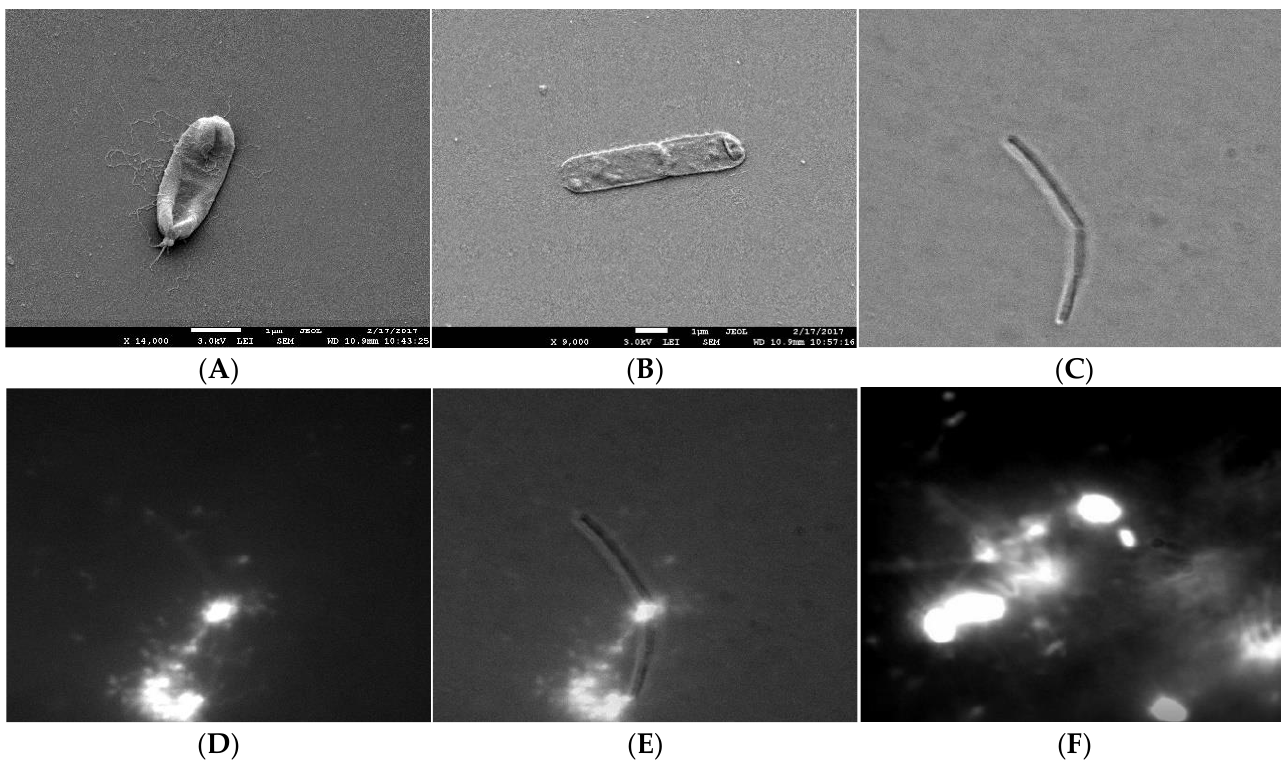
Figure 2. Release of cytosol material during cell lysis. ( A , B ) SEM micrograph of B. subtilis 3610 wt cells in SYM medium grown during cell lysis. The white arrow indicates rupture at the pole. Scale bar represents 1 µ m. ( C ) DIC micrograph of the lysing cell, ( D ) TOTO-1 fluorescence micrograph od the same lysing cell, ( E ) an overlay of the DIC and fluorescence image. ( F ) The released fluores- cence nucleic material from the dying cell (small fluorescence particles, filament structures, fuzzy cloud nucleic acid material) interconnecting the bacteria (the bright objects). To obtain the faint flu- orescence structures interconnecting neighbouring bacteria, the micrographs were overexposed.